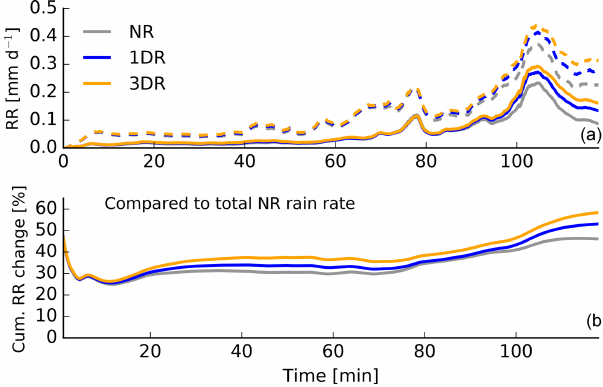
Figure 14. Total rain rate calculated from the trajectory en- semble simulation from recirculating parcels with a threshold of 0.01gkg − 1 . The dashed lines show the total rain rate, and the solid lines show the rain rate from recirculating parcels as well as the relative difference between the cumulated sum rain rates from re- circulating parcels compared to the cumulated sum total NR rain rate.